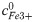
Experiments: Primary data for linear sweep voltammetry and representative kinetic curves at open circuit potential.A) Linear sweep voltammetry curve (scan rate = 10mV/s) of the system B) Disk current relaxation when disk potential is changed from cathodic pre-polarization (V = -1000mV) to the open circuit potential (V = -197mV) C) Ring current relaxation when ring current is held at the anodic limiting potential (V = 200mV) while disk potential is changed as in panel B. D) Ring current relaxation when ring current is held at the cathodic limiting potential (V = -1000mV) while disk potential is changed as in panel B. Rotation rate = 1000rpm, T = 25°C, cFe3+0 = 0.01M, cFe2+0 = 0.02M.